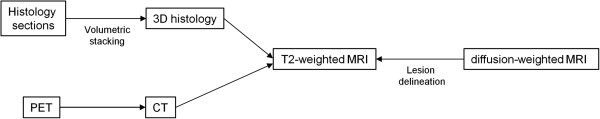
Schematic illustration of 3D image coregistrations performed in this study.